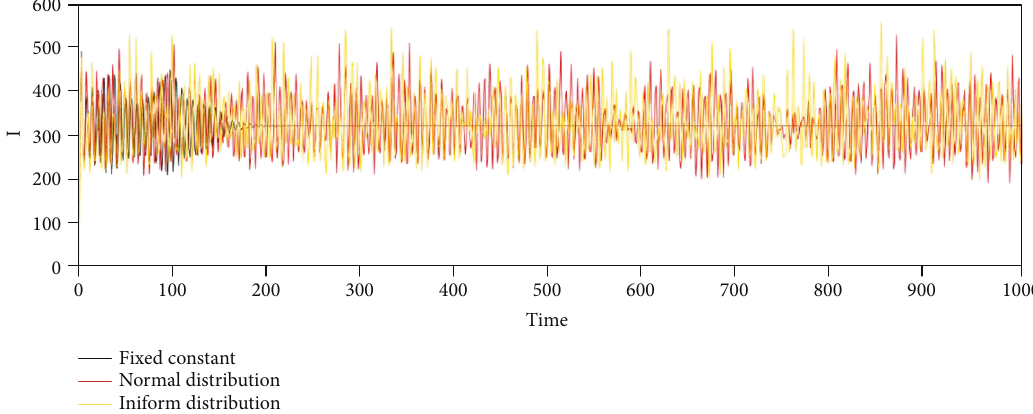
Figure 10: Change of initial inventory of warehouse allocation system in an unstable state under three demand scenarios.